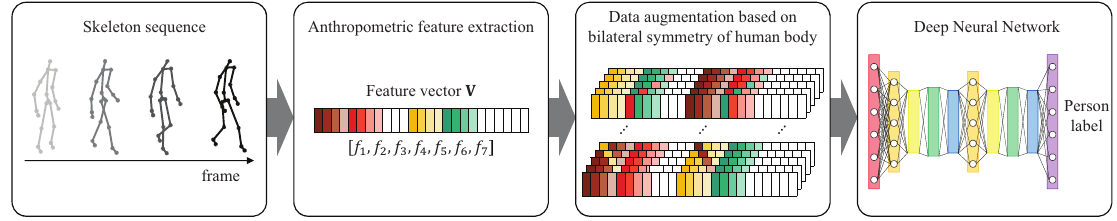
Figure 3. Schematic overview of proposed method for skeleton-based person